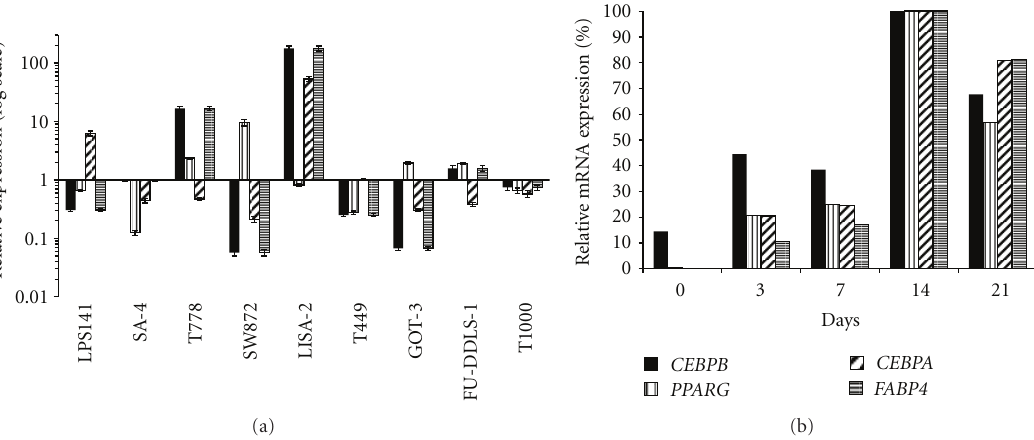
Figure 2: Expression of adipocytic di ff erentiation markers. (a) The basal mRNA levels of CEBPB , CEBPA , PPARG, and FABP4 normalized to TBP were determined in the 9 LPS cell lines and presented relative to the average expression of each gene (log scale). (b) Primary hMSCs were subject to adipocytic di ff erentiation for 21 days. CEBPB , CEBPA , PPARG, and FABP4 (normalized to GAPDH ) were determined by qRT-PCR at indicated time points. Data is presented relative to day 14 (set as